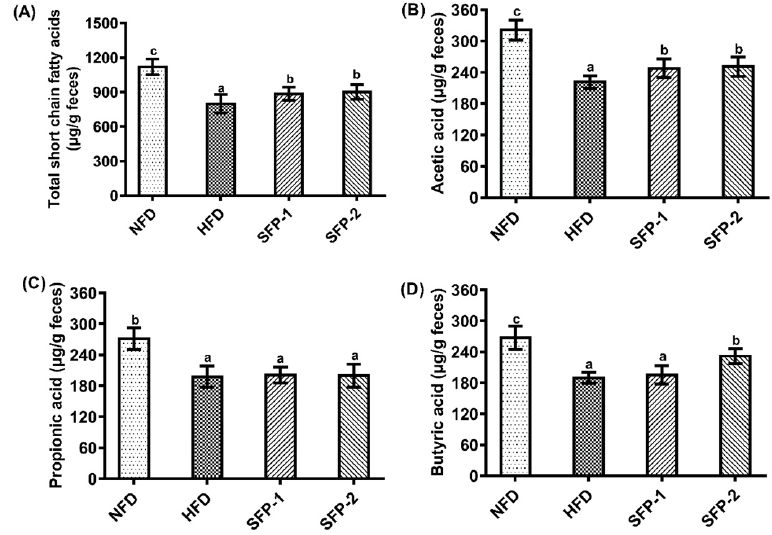
Figure 4. Effects of SFPs on production of short chain fatty acids in diabetic rats. Total short chain fatty acids ( A ), acetic acid ( B ), propionic acid ( C ) and butyrate ( D ). The different letters represent significant difference ( p <